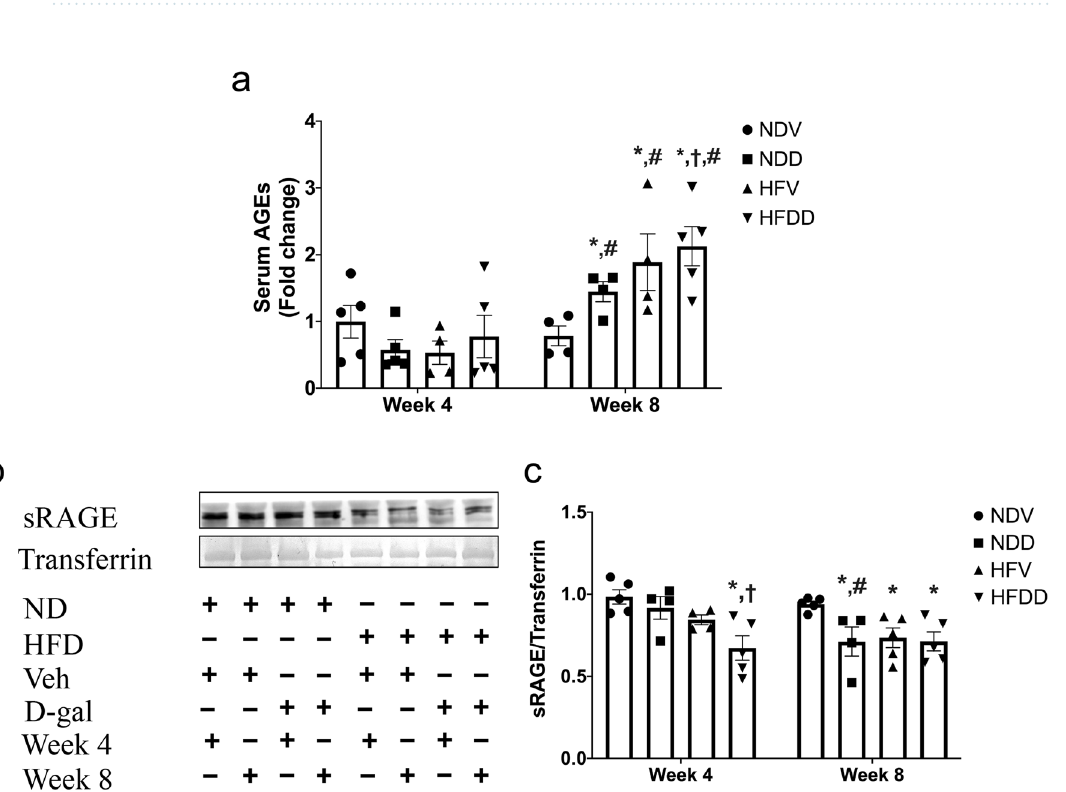
Figure 1. D-galactose-induced aging aggravated aging-related biomarkers in the obese-insulin resistant condition. ( a ) Quantification of serum AGEs level in NDV, NDD, HFV, HFDD at 4-week and 8-week timepoints, ( b , c ) sRAGE protein expression relative to transferrin as analyzed by western blotting. Bar graphs presented as mean ± SEM (n = 4–6/group). * p < 0.05 versus NDV at the same time point, † p < 0.05 versus NDD at the same time point, ‡ p < 0.05 versus HFV at the same time point, # p < 0.05 versus same group at the different time point. AGEs, advanced glycation end products; HFDD, high-fat diet with D-galactose; HFV, high-fat diet with vehicle; NDD, normal diet with D-galactose; NDV, normal diet with vehicle; sRAGE, soluble receptor for advanced glycation end